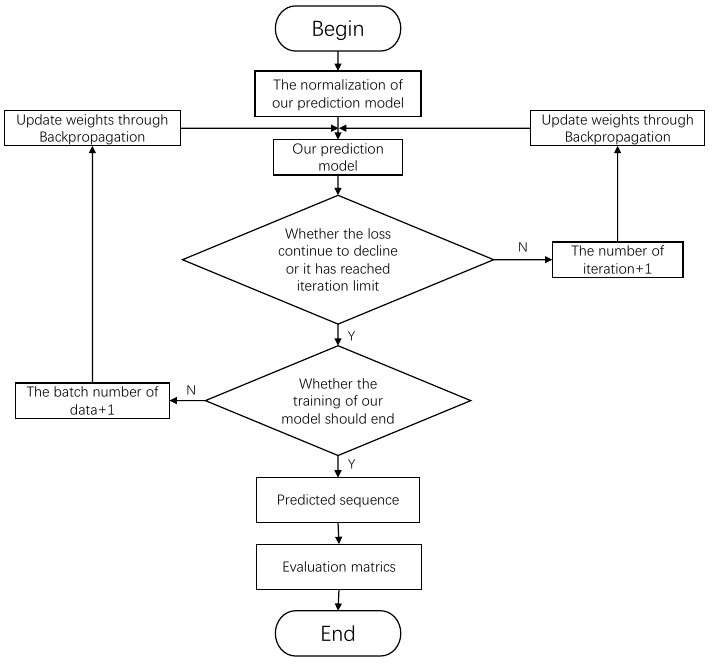
Figure 9. The training flow chart.